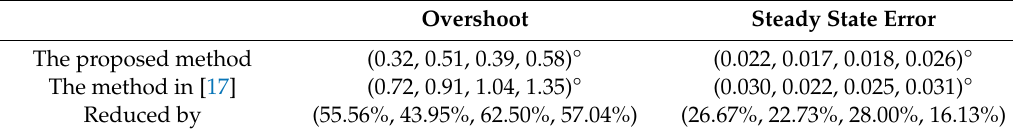
Table 2. Statistical Results of Figure 3a. Table 3. Statistical Results of Figure